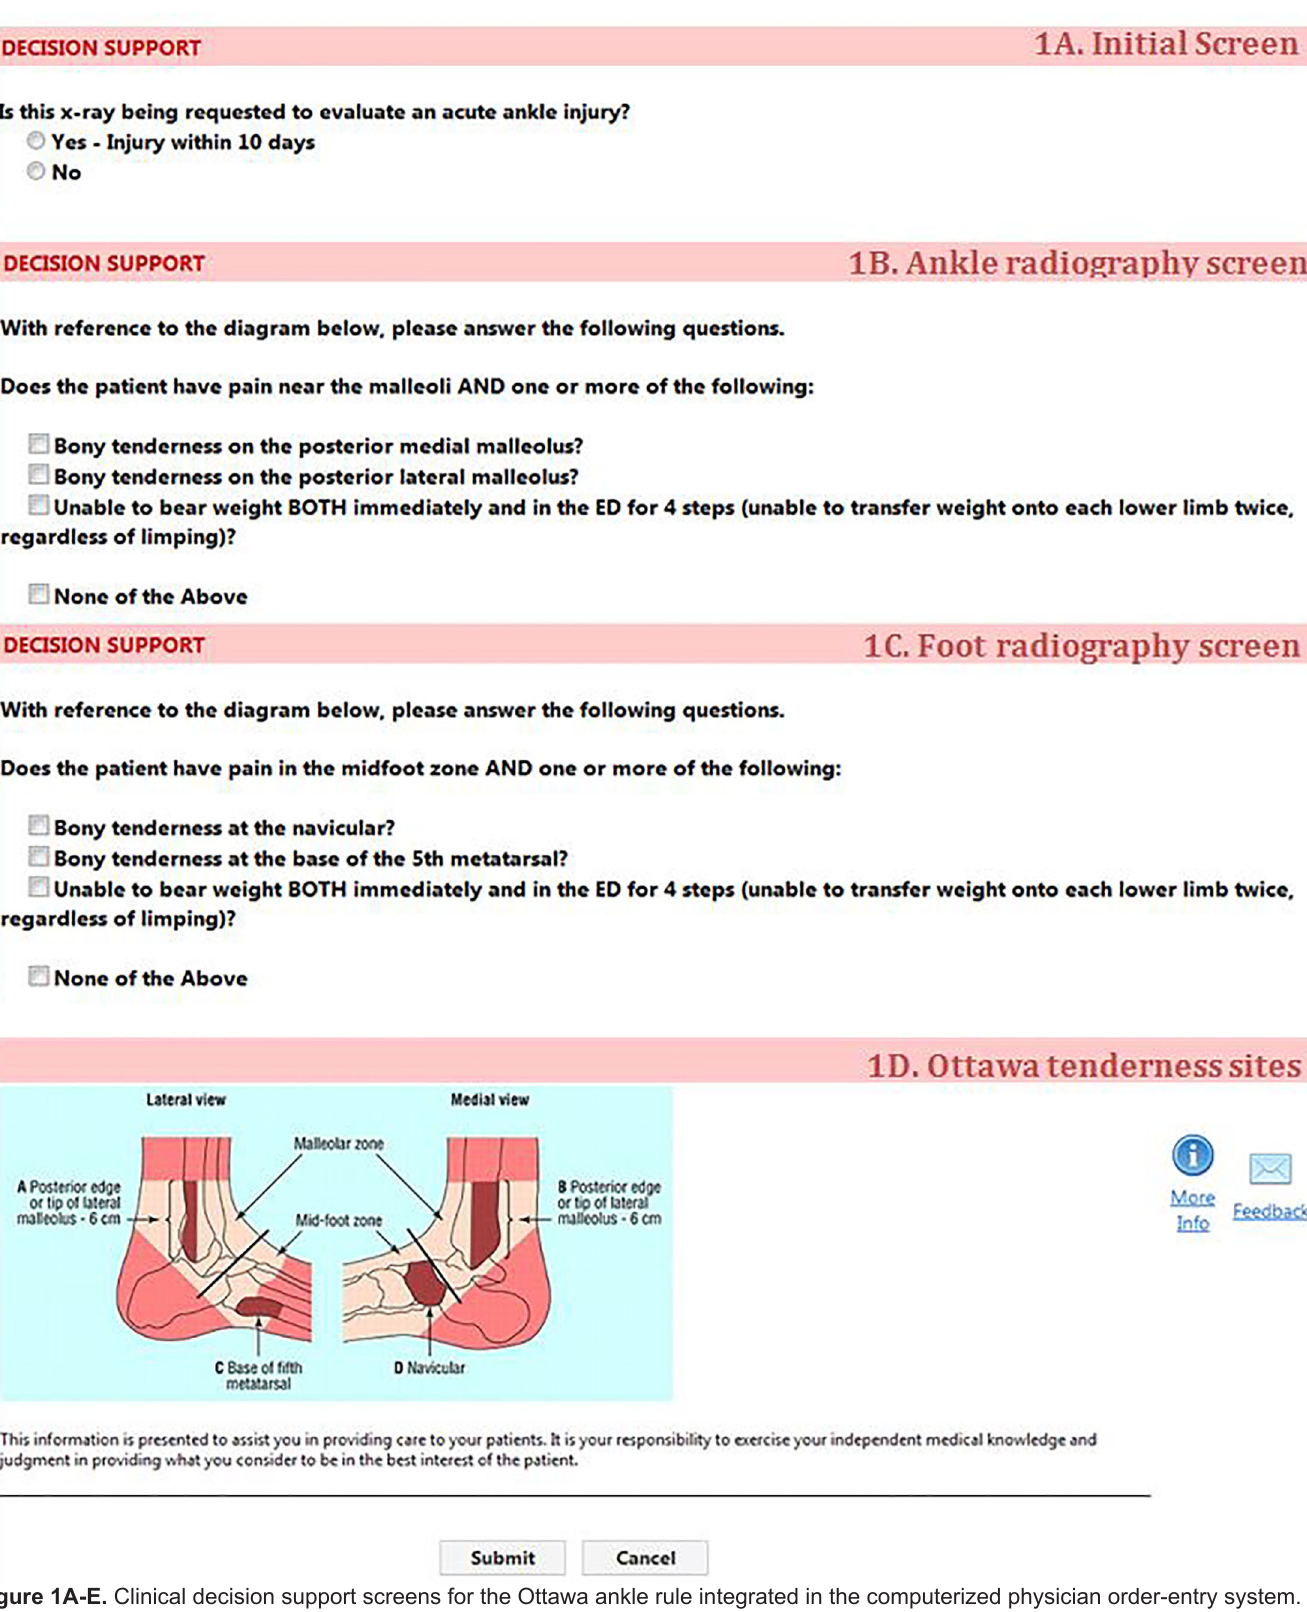
Figure 1A-E. Clinical decision support screens for the Ottawa ankle rule integrated in the computerized physician order-entry